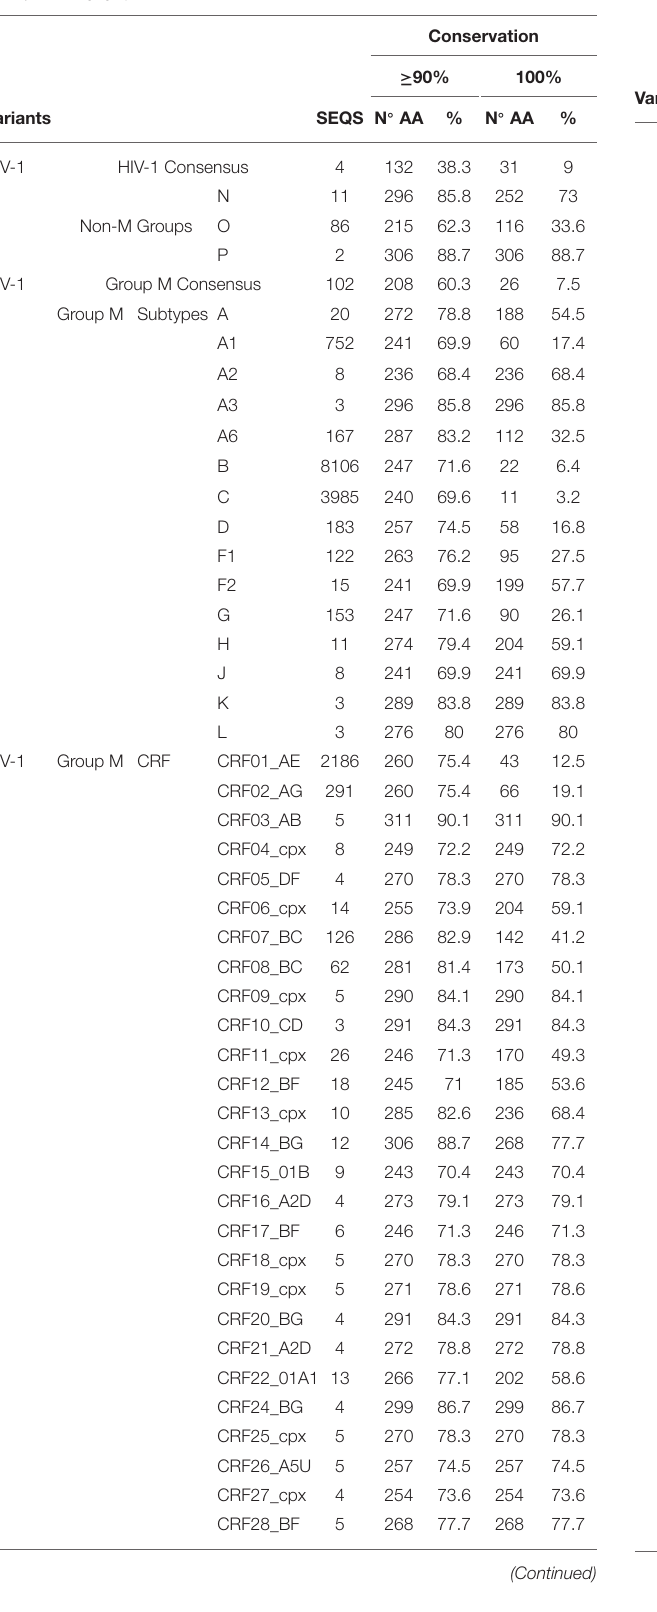
TABLE 2 | Number and percentage of highly ( ≥ 90%, 100%) conserved aa per HIV-1/HIV-2 variant.